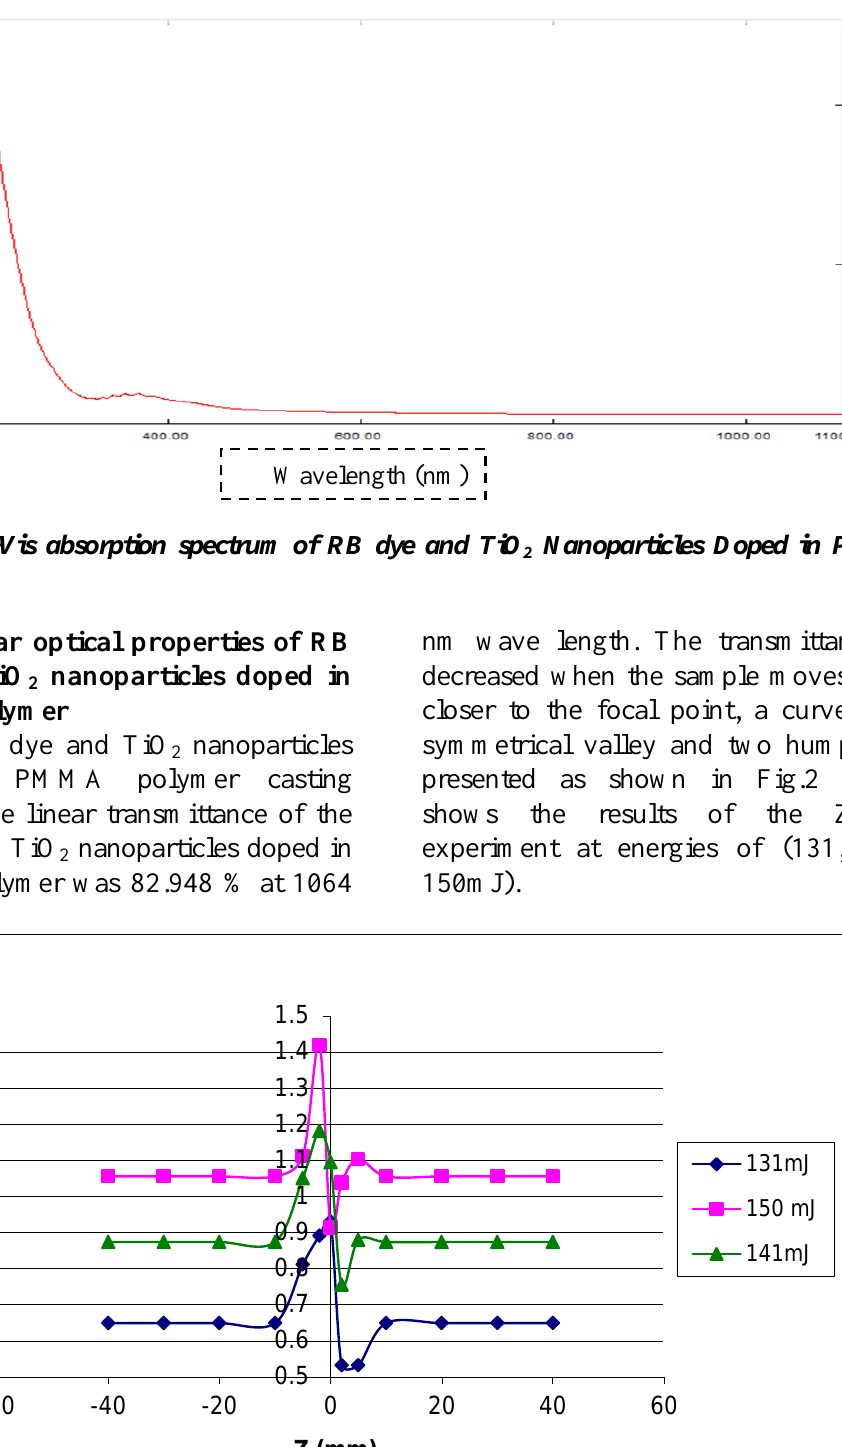
Fig. 2: Closed-aperture of sample for (131, 141 and 150) mJ at